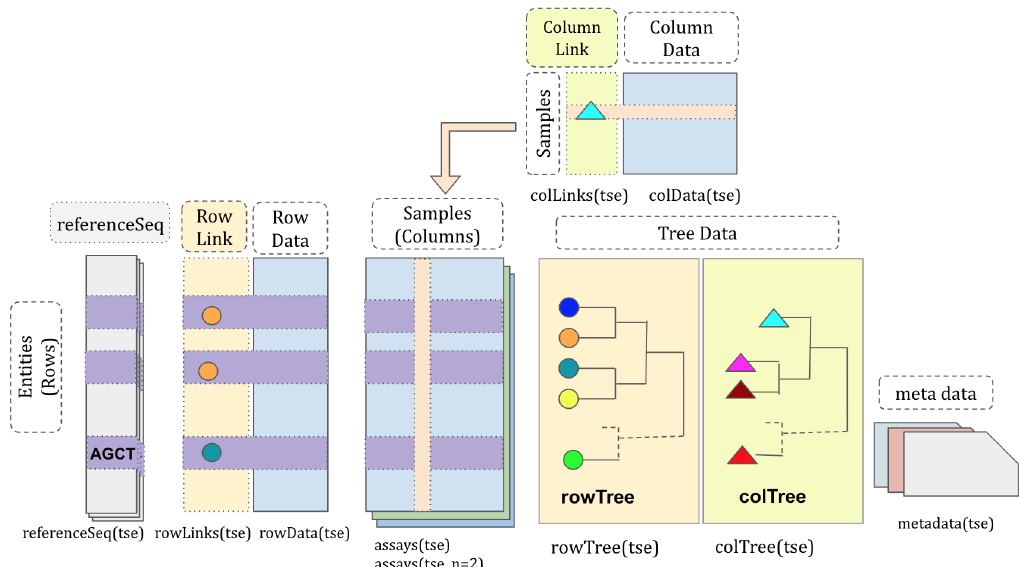
Figure 1. The structure of the TreeSummarizedExperiment class. The rectangular data matrices are stored in assays . Each matrix usually has rows representing entities (e.g., genes or microbial taxa) and columns representing cells or samples. Information about rows and columns is stored in rowData and colData , respectively. The hierarchy structure on rows or columns is stored in rowTree or colTree respectively, and the link information between rows/ columns and nodes of the row/column tree is in rowLinks/colLinks . referenceSeq is an optional slot to store the sequence information for